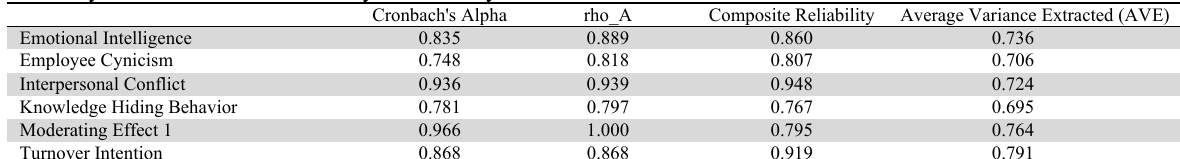
The study variables’ internal reliability and Validity